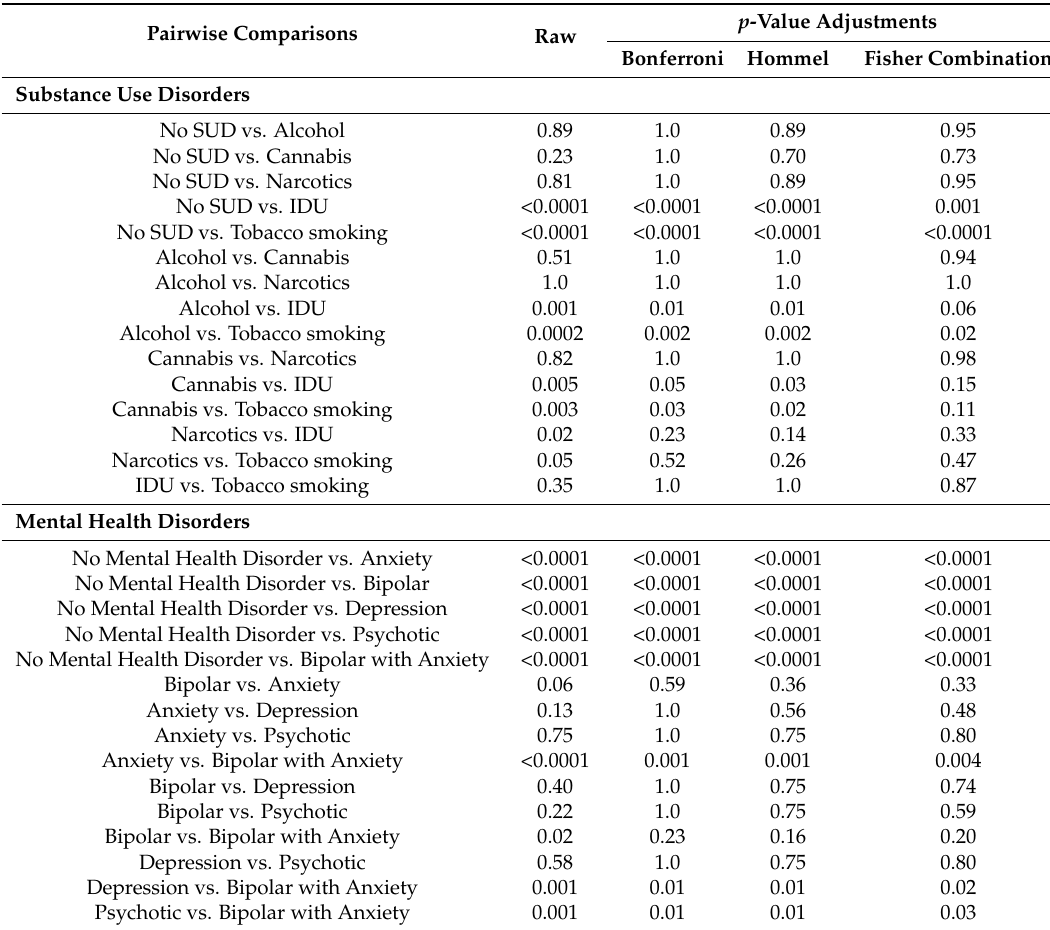
Table 7. p -Value adjustment for multiple